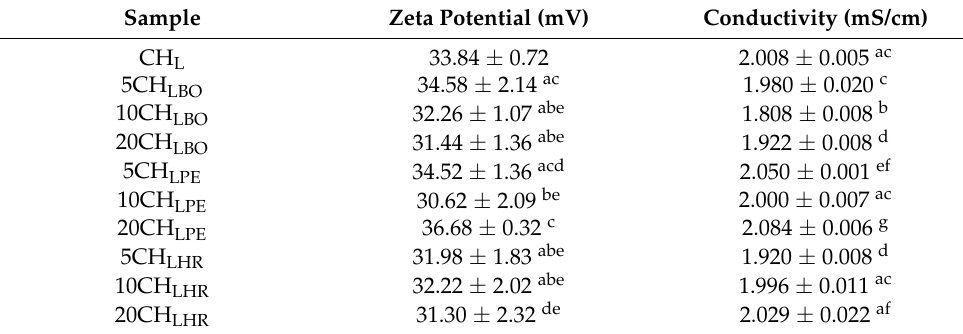
Table 2. Zeta-potential of film forming solution.